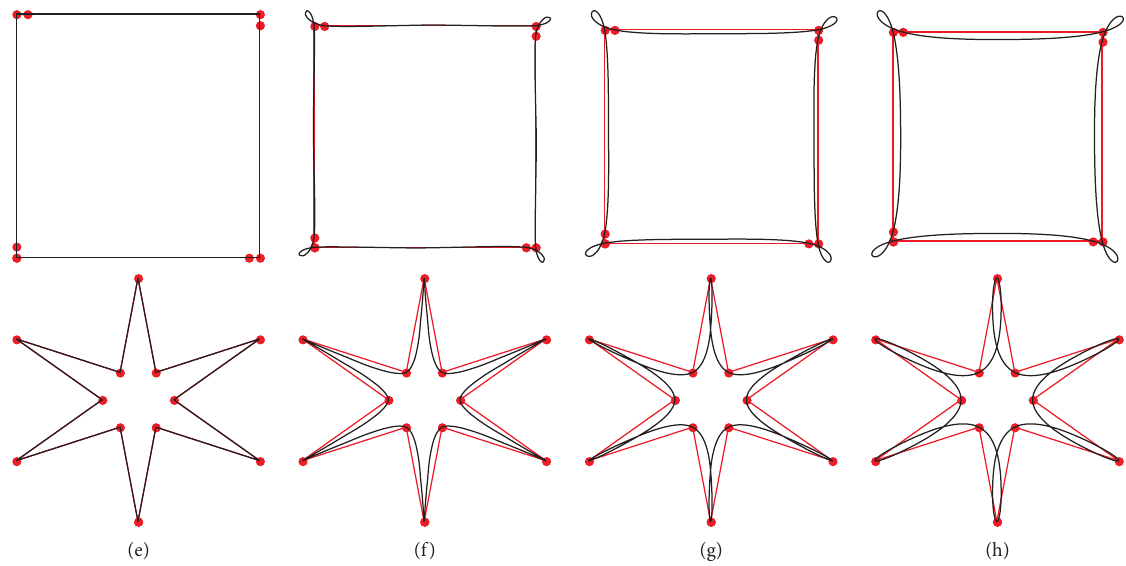
Figure 6: Black curves are the limit curves obtained by subdivision scheme S a 7 in (a–d) and by subdivision schemes of Deslauriers and Dubuc [1] in (e–h), respectively: (a) α � 1/2048 , β � 1/512; (b) α � 1/100 , β � − 1/128; (c) α � 1/128 , β � 1/512; (d) α � 1/80 , β � 1/80; (e) 2- point scheme; (f) 4-point scheme; (g) 6-point scheme; (h) 8-point